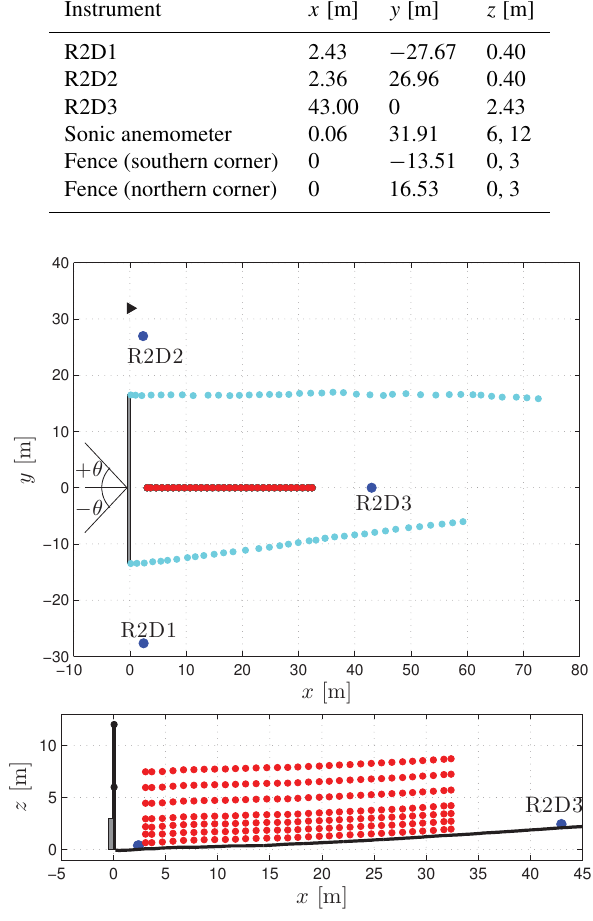
Figure 4. The fence experiment in the reference coordinate system. The positions of the fence (gray rectangle), the lidars (blue circles), the mast (black triangle and black thick line), scanning grid (red circles), and GPS measurements (cyan circles) are also illustrated both at the top (top) and side (bottom) views. The terrain elevation is also shown in the side view